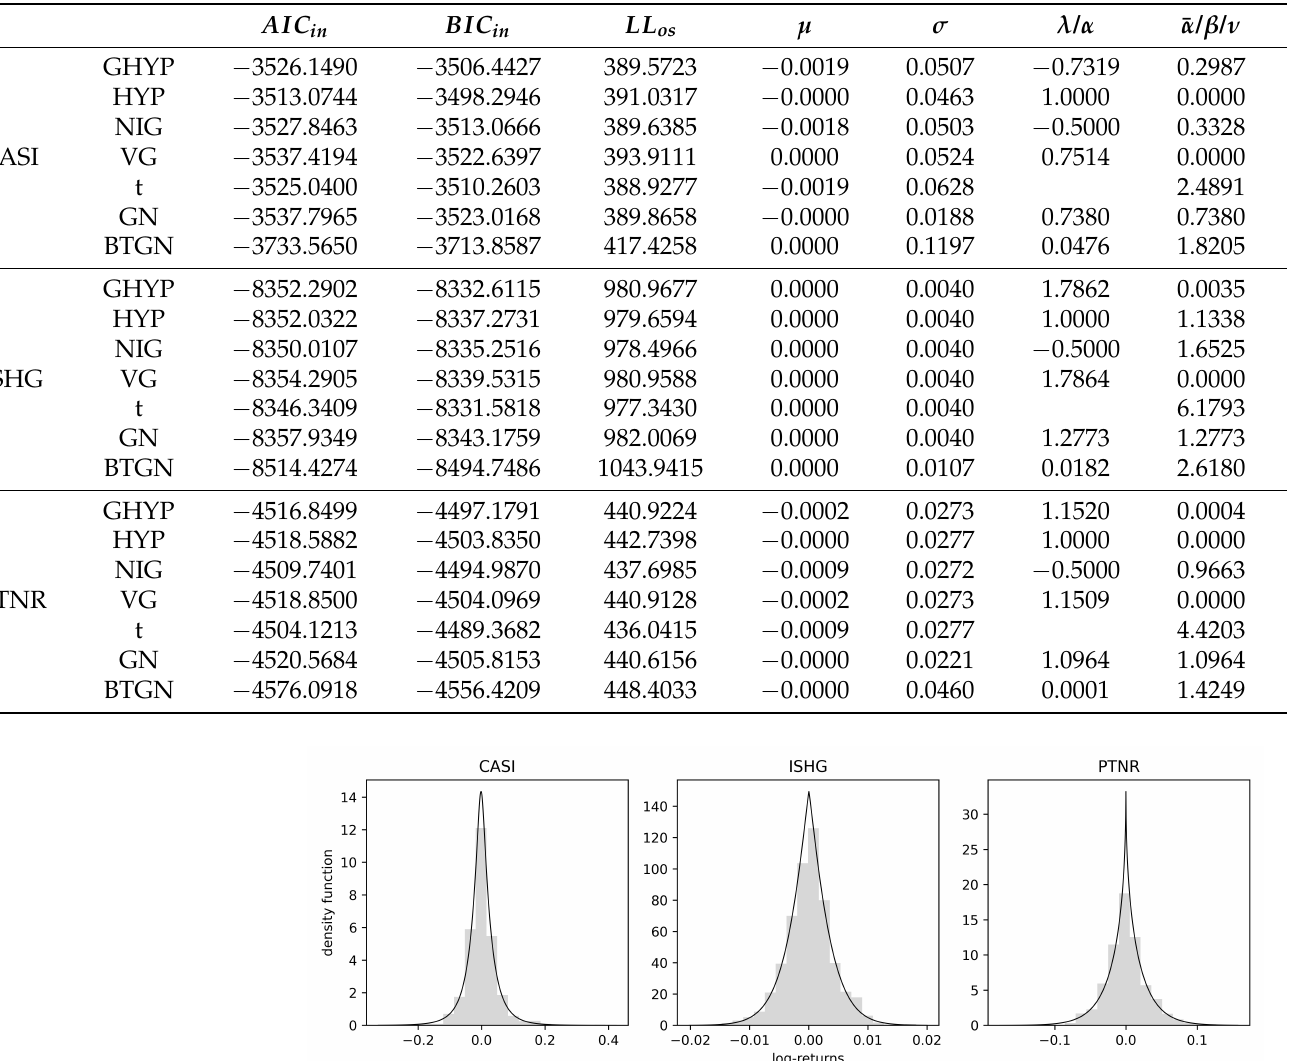
Table 2. Table of distributions fitted to log-returns data with in-sample criterion and out-of-sample log-likelihood (LL).